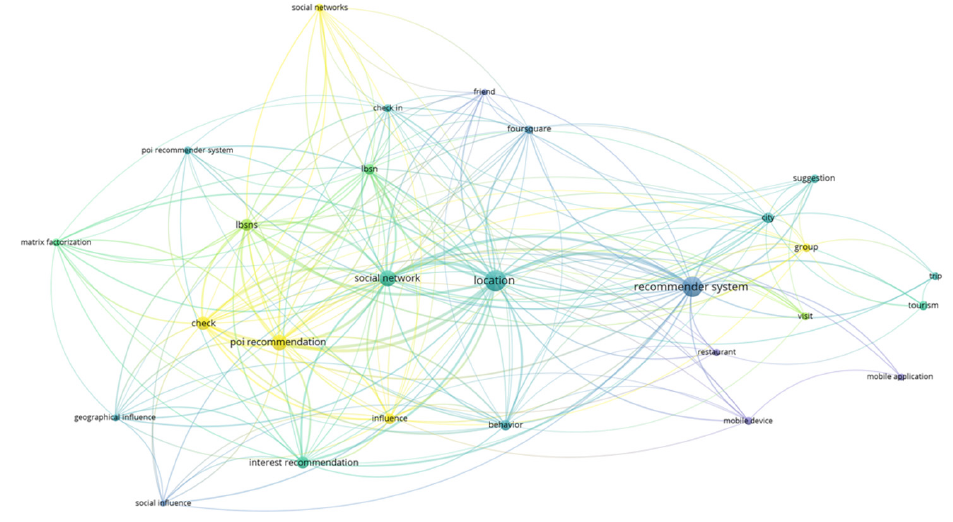
Figure 2. Network connections for the POI recommendation keywords with VOSviewer.